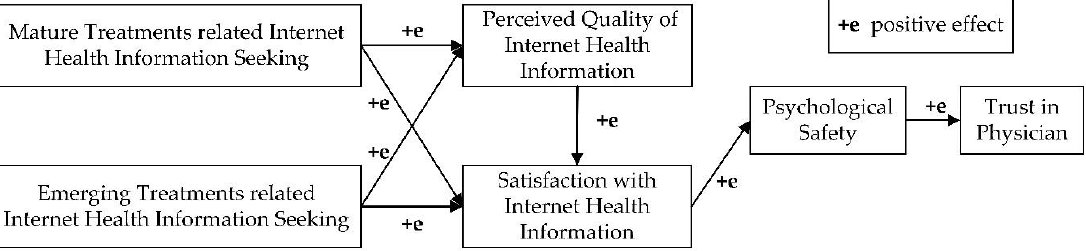
Figure 3. Modified Research Model.